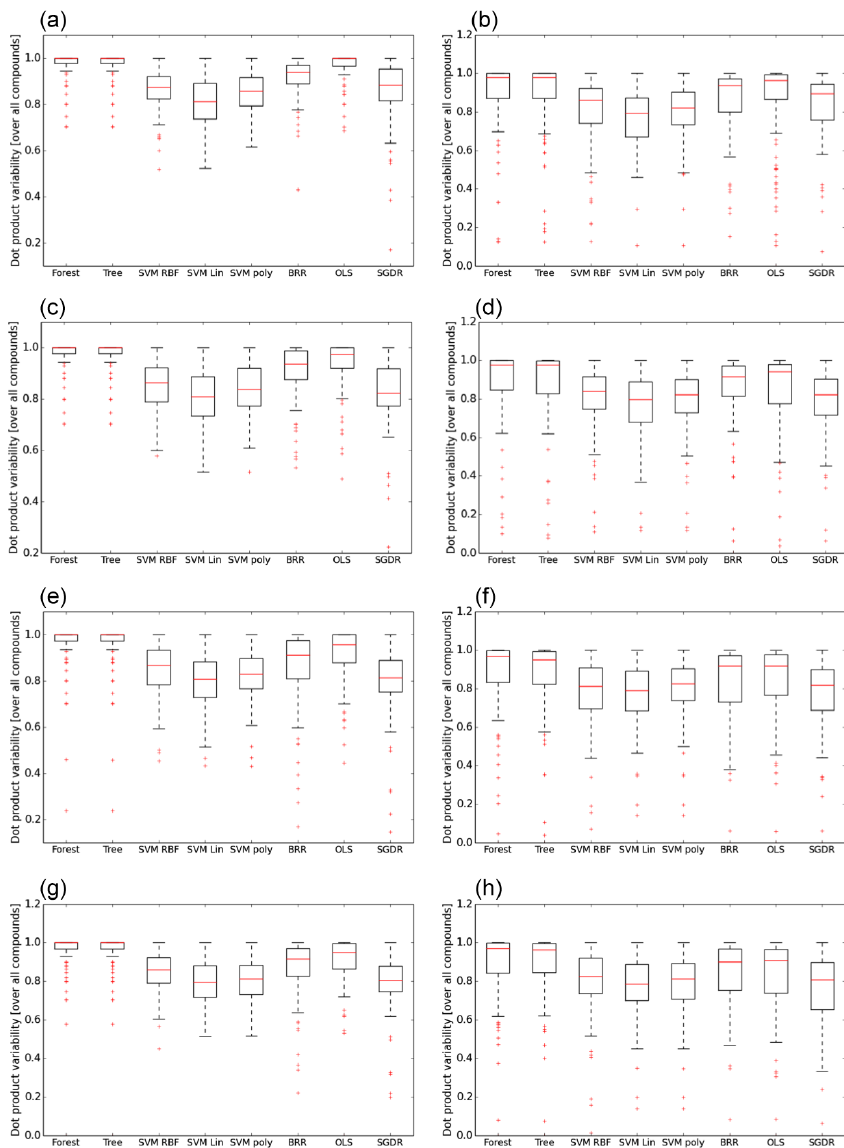
Figure 4. (a) Spread of the cosine angle between experimental and predicted mass spectra ( y axes) for all 100 compounds in the AMS library as a function of the supervised method ( x axes) using the MACCS fingerprint. Left: using all compounds in the training process. Right: using 80% of the compounds in the training process with variable selection. The method labels are as follows: SMV (support vector machine with three kernels (RBF, Poly(nomial), and Lin(near))); BRR: Bayesian ridge; OLS: ordinary least squares; SGDR: stochastic gradient descent; Tree: decision tree; and Forest: random forest. (b) Spread of the cosine angle between experimental and predicted mass spectra ( y axes) for all 100 compounds in the AMS library as a function of the supervised method ( x axes) using the FP4 fingerprint. Left: using all compounds in the training process. Right: using 80% of the compounds in the training process with variable selection. The method labels are as follows: SMV (support vector machine with three kernels (RBF, Poly(nomial), and Lin(near))); BRR: Bayesian ridge; OLS: ordinary least squares; SGDR: stochastic gradient descent; Tree: decision tree; and Forest: random forest. (c) Spread of the cosine angle between experimental and predicted mass spectra ( y axes) for all 100 compounds in the AMS library as a function of the supervised method ( x axes) using the AIOMFAC fingerprint. Left: using all compounds in the training process. Right: using 80% of the compounds in the training process with variable selection. The method labels are as follows: SMV (support vector machine with three kernels (RBF, Poly(nomial), and Lin(near))); BRR: Bayesian ridge; OLS: ordinary least squares; SGDR: stochastic gradient descent; Tree: decision tree; and Forest: random forest. (d) Spread of the cosine angle between experimental and predicted mass spectra ( y axes) for all 100 compounds in the AMS library as a function of the supervised method ( x axes) using the Nanoolal fingerprint. Left: using all compounds in the training process. Right: using 80% of the compounds in the training process with variable selection. The method labels are as follows: SMV (support vector machine with three kernels (RBF, Poly(nomial), and Lin(near)); BRR: Bayesian ridge; OLS: ordinary least squares; SGDR: stochastic gradient descent; Tree: decision tree; and Forest: random